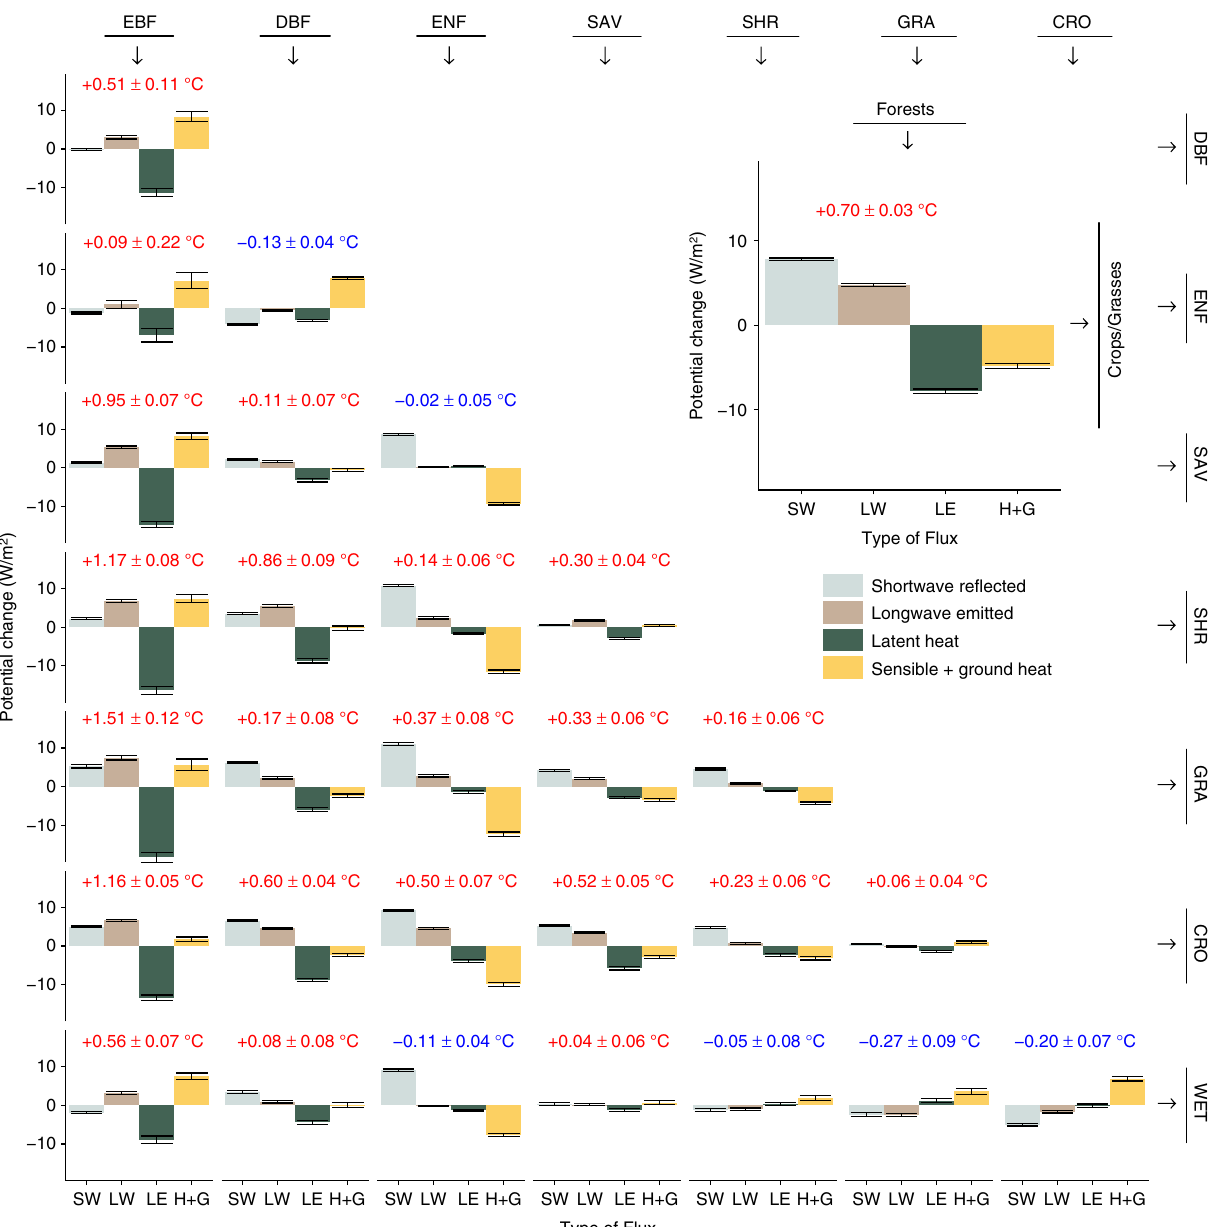
Fig. 3 Global summary of the mean annual potential change in surface energy balance and temperature for various transitions in vegetation type as derived from satellite observations. The transitions shown involve the following vegetation classes: evergreen broadleaf forests (EBF), deciduous broadleaf forests (DBF), evergreen needleleaf forests (ENF), savannas (SAV), shrublands (SHR), grasslands (GRA), croplands (CRO) and wetlands (WET). Because transitions are symmetric, reverse transitions can be derived by inverting the sign. The inset shows a more generic transition from forests to either crops or grasses corresponding to the maps shown in Figs. 1 and 2. For each transitions, the mean change is provided for the shortwave re fl ected radiative fl ux (SW), longwave emitted radiative fl ux (LW), latent heat fl ux (LE) and the combination of sensible and ground heat fl uxes (H+G). The number above the bars represents the mean surface temperature change observed for that transition ± two times the standard error around the mean, as do the con fi dence intervals represented on the bar charts of the fl ux